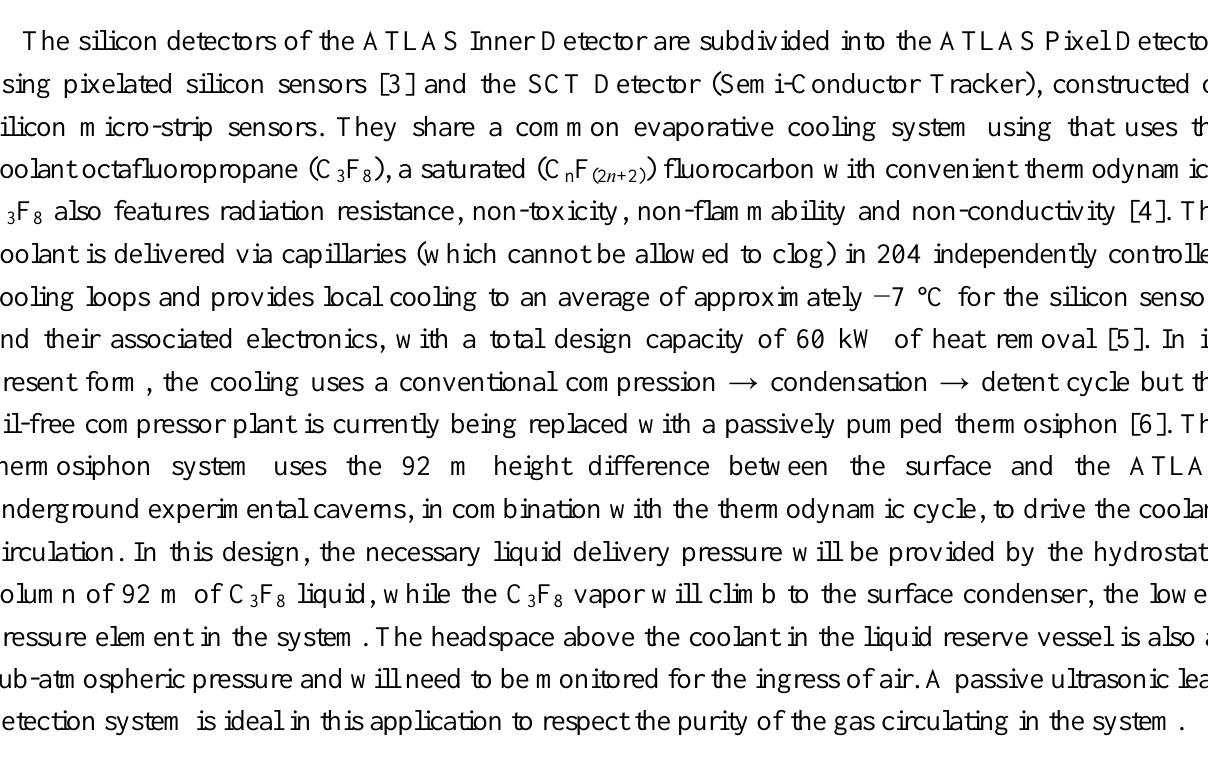
Figure 1. The speed of sound in a gas mixture can be very sensitive to the ratio of the two components, depending on the difference in their molecular